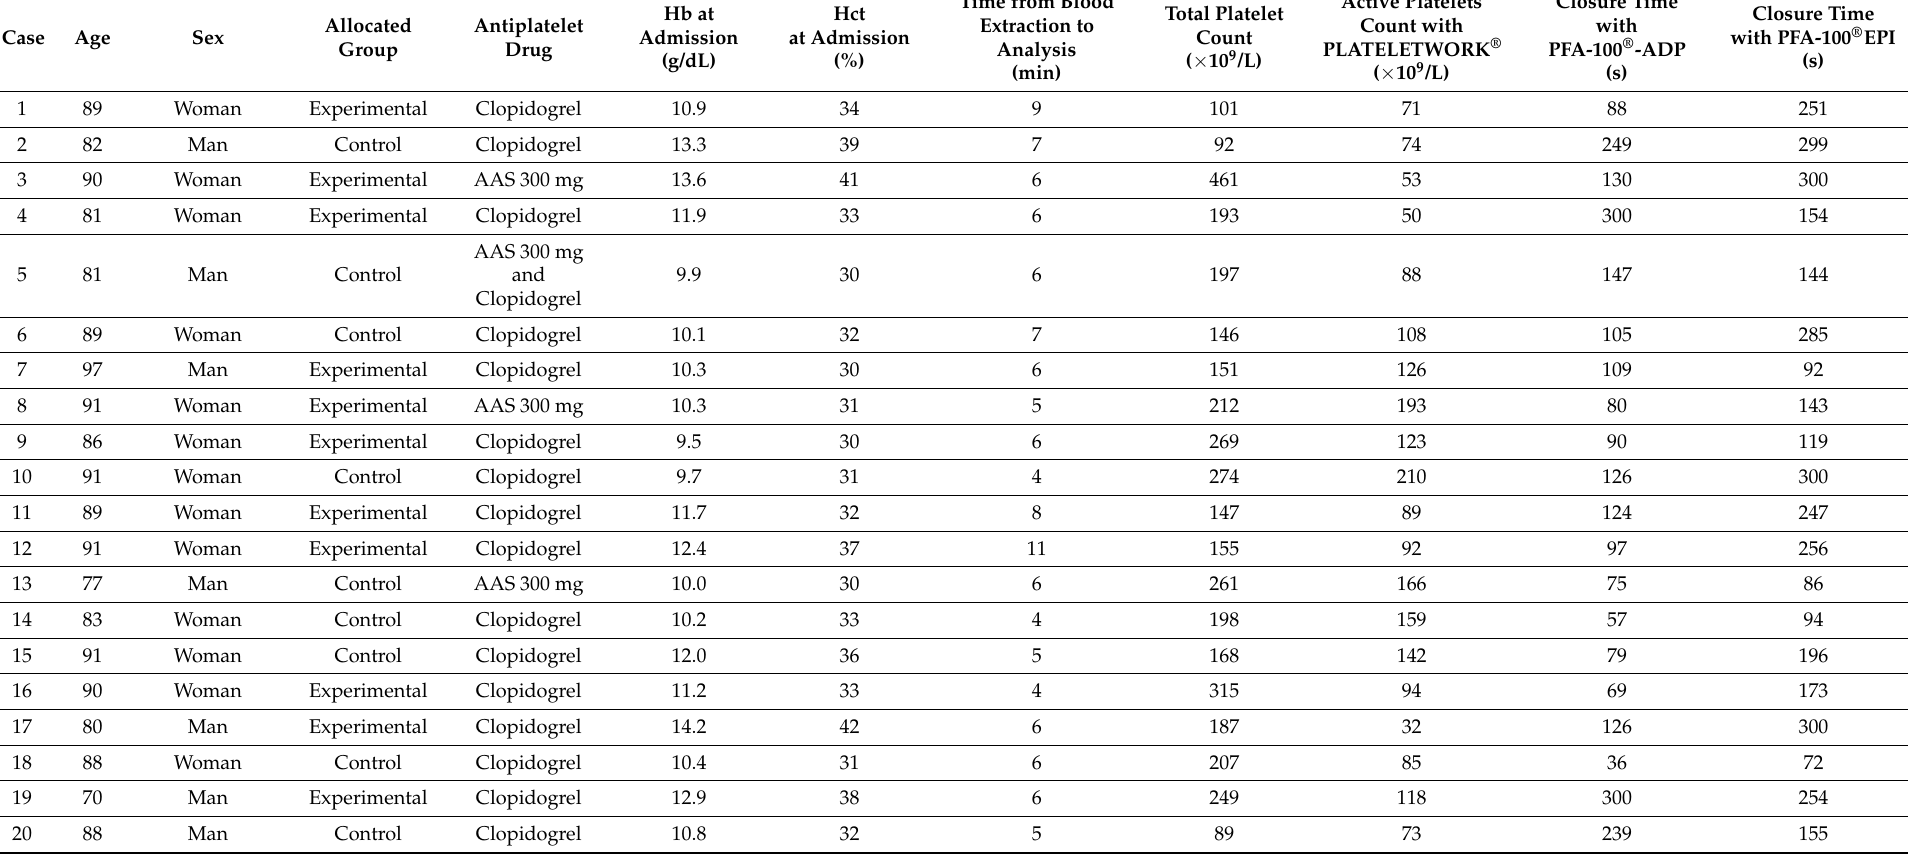
Table 1. Characteristics of included patients and test